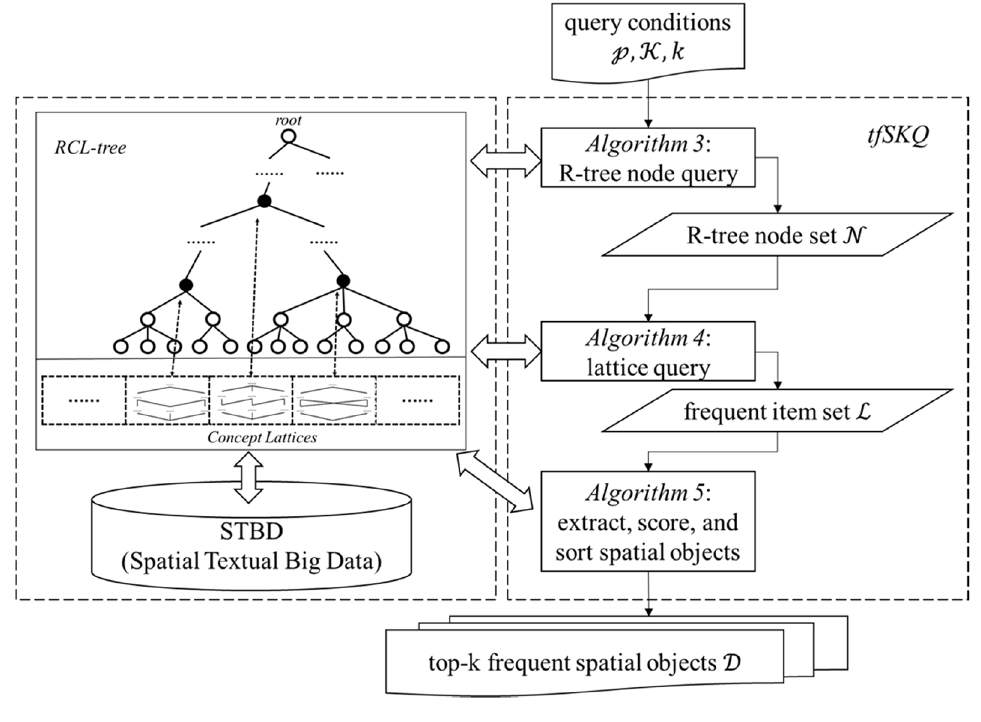
Figure 2. Schematic overview of